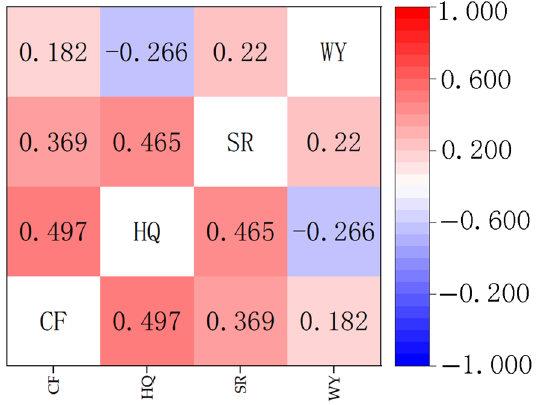
Figure 4. Trade-off and synergy analysis of ecosystem services in southern Anhui.